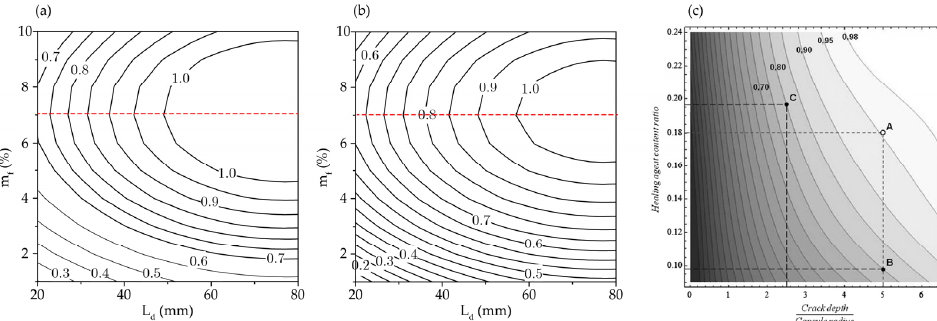
Figure 16. Contour plot of hitting probability 𝑃 (cid:3035) as a function of L D and m f for ( a ) 𝑑 = 0.2 mm, 𝐿 (cid:3050) = 0.3 mm and ( b ) 𝑑 = 0.6 mm, 𝐿 (cid:3050) = 0.3 mm ; ( c ) Hitting probability as a function of normalized crack depth and volume fraction of capsules, for a cube of side length equivalent to 1cm containing 27 capsules, with V capsule /V cube varying from 0.1–0.3 [19].